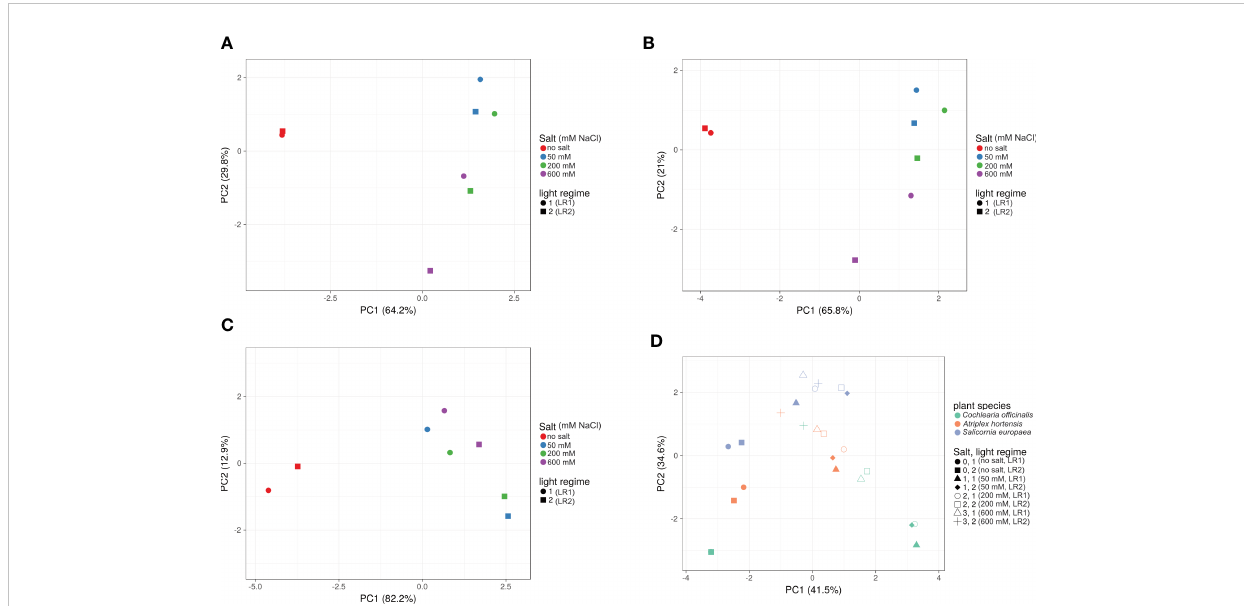
FIGURE 4 Effect of salt treatment and light regime on metabolite pro fi le. PCA plots of (A) Cochlearia of fi cinalis , (B) Atriplex hortensis , (C) Salicornia europaea , and (D) all three plant species. PCA plots were generated with ClustVis; n = 8 pools of three individual plants each from two independent experiments; unit variance was applied to rows; SVD with imputations is used to calculate principal components; factor loadings are provided in Appendix (B) Light regime 1 (LR1, greenhouse); light regime 2 (LR2, indoor